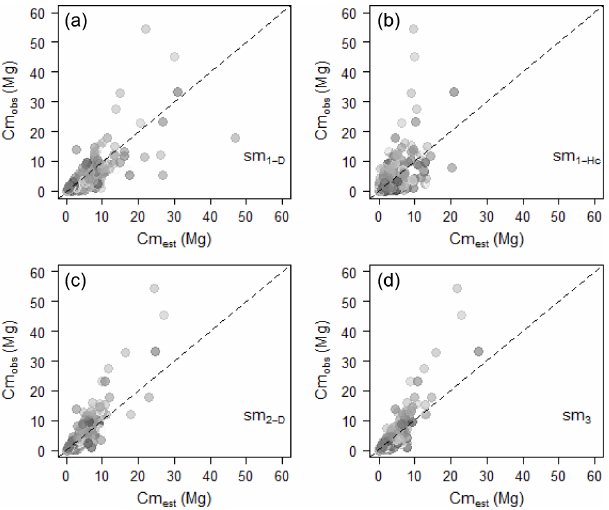
Figure A1. Observed against estimated crown mass (in Mg) for models sm 1-D (a) , sm 1-Hc (b) , sm 2-D (c) , sm 3 (d) . Models were cal- ibrated on Data CM2 . Tree wood density was standardized to range between 0 and 1 and represented as a greyscale (with black the low- est values and white the highest